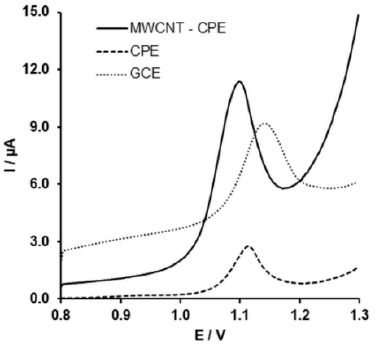
Figure 7. Differential pulse voltammogram (DPV) of 2.5 × 10 − 5 M SIM in 0.1 M H 2 SO 4 at various electrodes; step potential: 5 mV; modulation amplitude: 100 mV; modulation time: 0.04 s; interval time: 0.1 s.